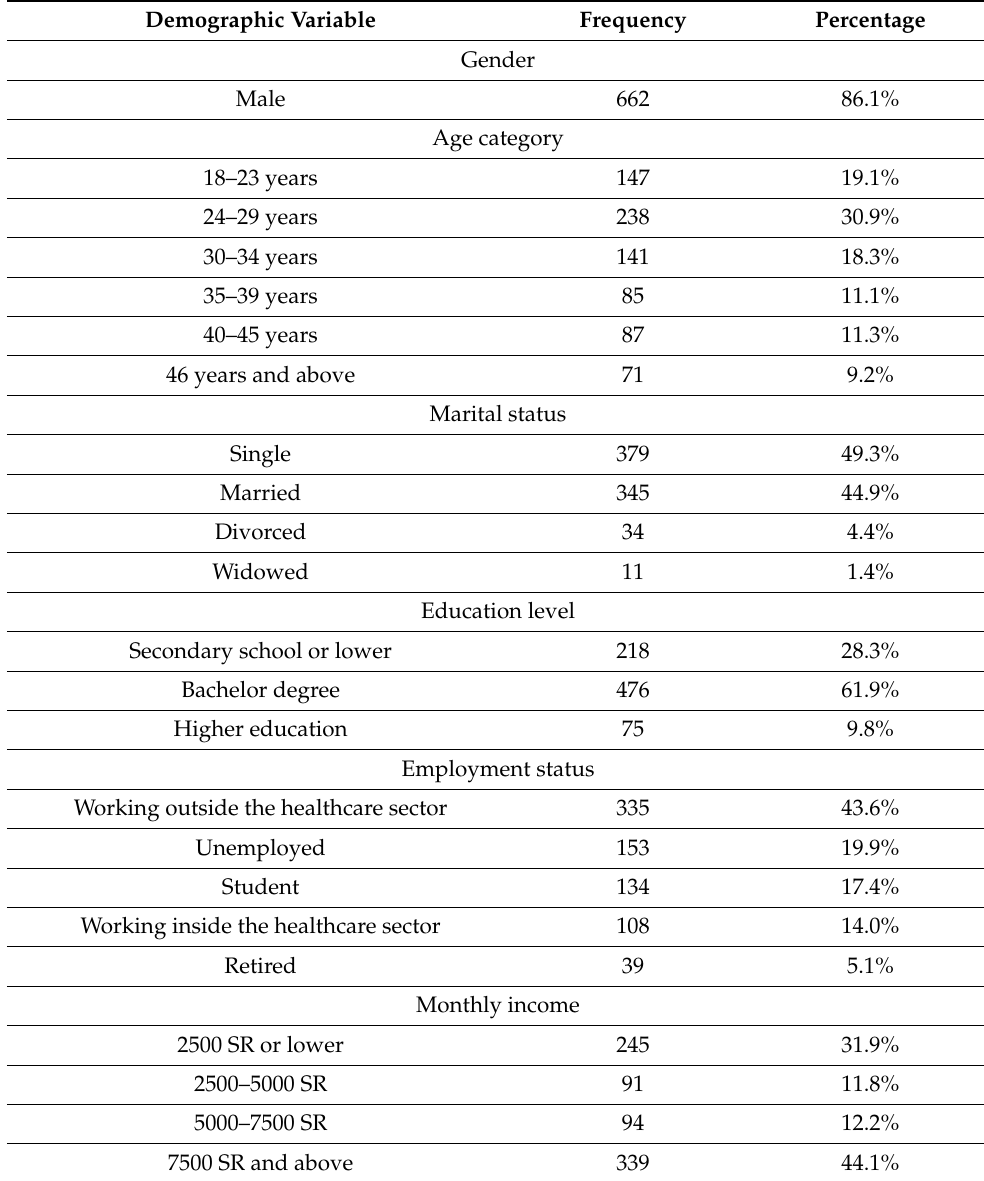
Table 1. Participants demographic